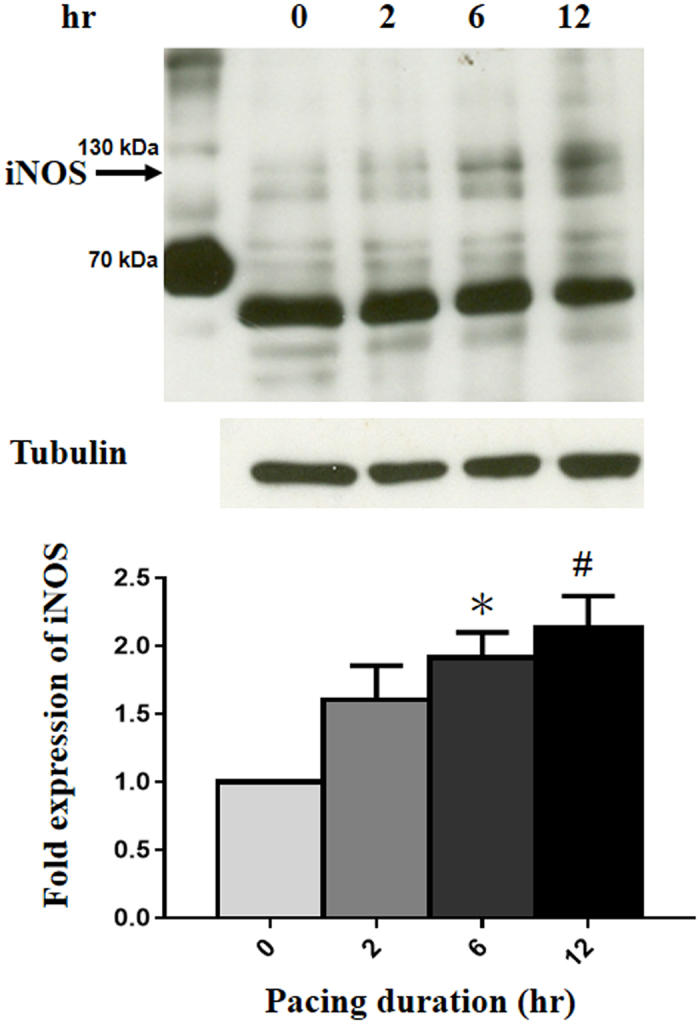
Tachypacing of HL-1 induced iNOS expression.HL-1 cells were subjected to 4 Hz pacing for the indicated times. Bottom panel: the relative expression levels of iNOS and tubulin were quantified by densitometry and normalized to the control level, which was set at 1.0. Each value represents the mean ± SE of four independent experiments. One-way ANOVA with post hoc Tukey’s tests was applied for two groups and multiple comparisons. *P = 0.027 versus the controls. #P = 0.007 versus the controls.